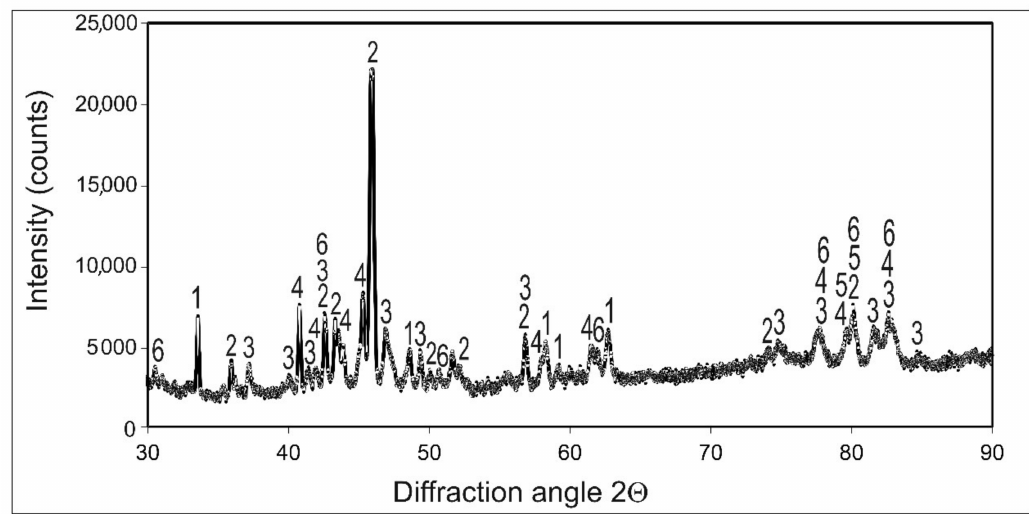
Figure 2. XRD patterns of gas-borided Inconel 600-alloy; 1—NiB, 2—Ni 2 B, 3—Ni 3 B, 4—Ni 4 B 3 , 5—CrB, 6—Cr 2 B.